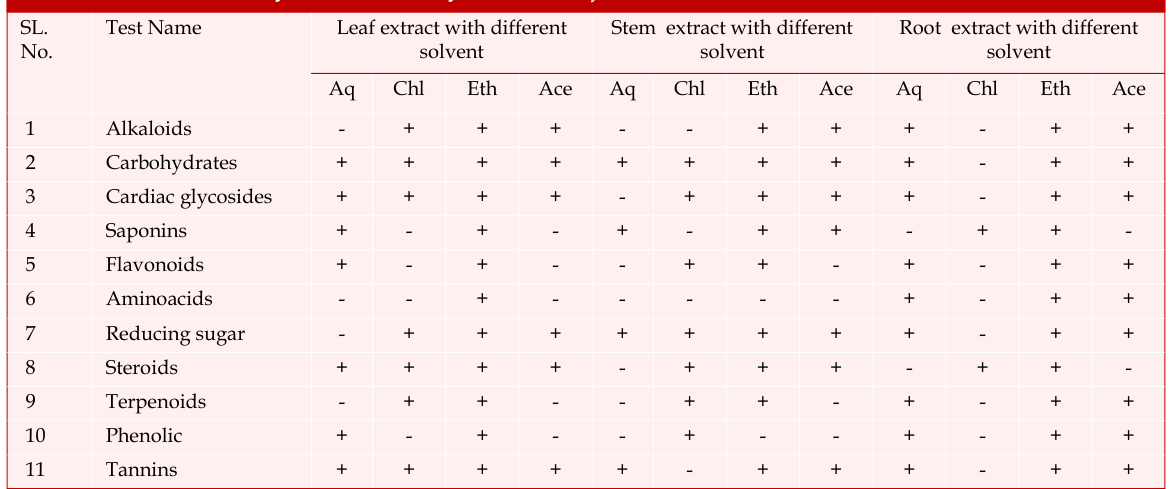
Phytochemical analysis of Coleus forskohlii with different solvent SL.